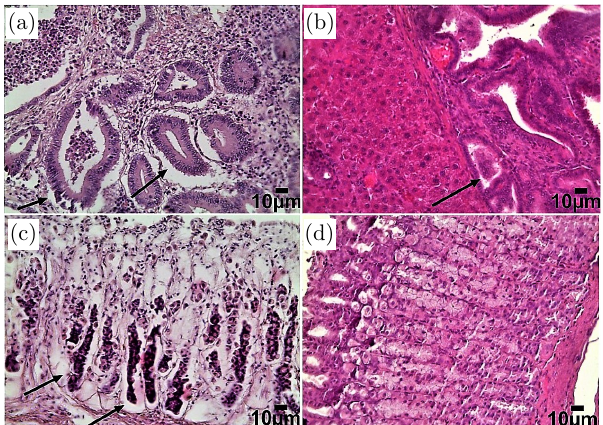
Fig. 1. Histological analysis of the tissues of the stomach and liver in normal rats living under standard conditions and in rats underwent chronic stress and receiving nitrites and toluidine in water and food for 9 months: (a) adenocarcinoma of the stomach with high heterogeneity (indicated by an arrow), (b) metastasis (indicated by the arrow) in the tissues of the liver, (c) dysplasia of the basal glands of the stomach (marked with an arrow) that is a precancer indicator and (d) normal gastric mucosa. Hematoxylin and Eosin staining. Bars represent 10 m